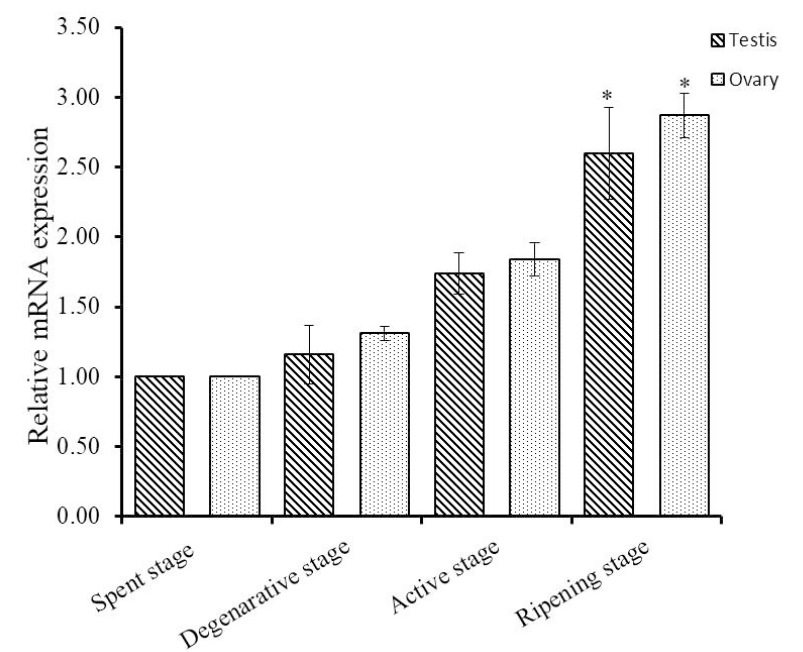
Figure 6. Expression levels of Hdh IGFBP-5 mRNA in H. discus hannai gonad at different gametogenetic stages. The expression level in the gonad at spent stage is set as 1 to calibrate expression levels in the gonad at other stages. Asterisks indicate significant differences ( p < 0.05) in ripening stage than other stages.